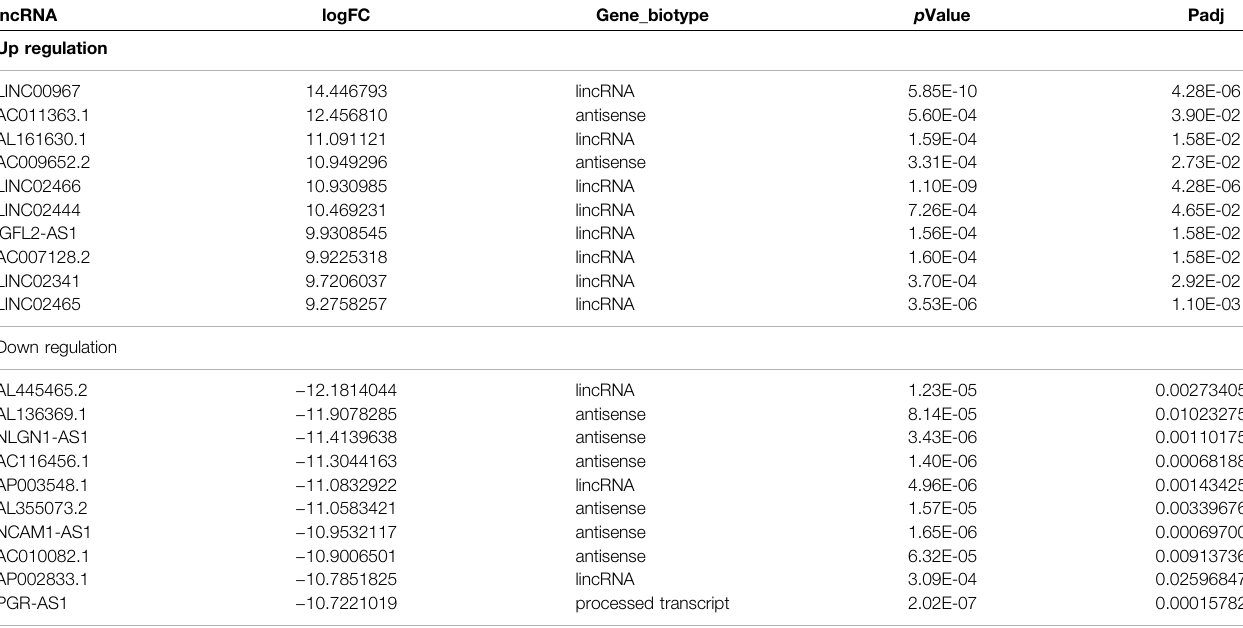
TABLE 1 | Top10 (up- and down-regulated) of differentially expressed lncRNAs in bladder cancer and adjacent tissues. lncRNA logFC